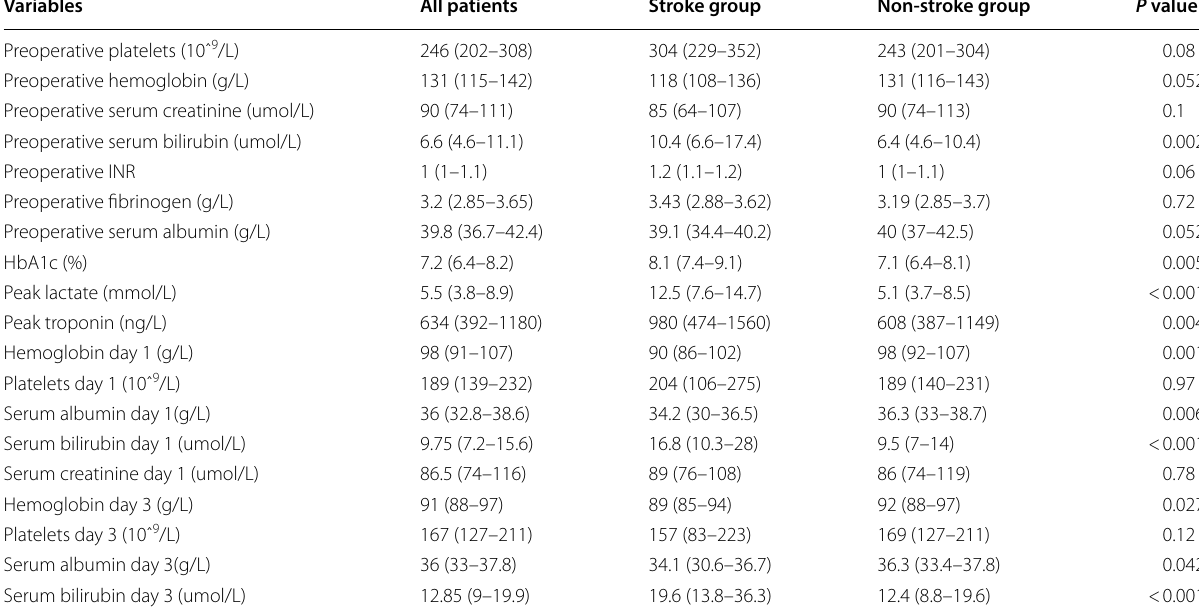
Table 2 Laboratory